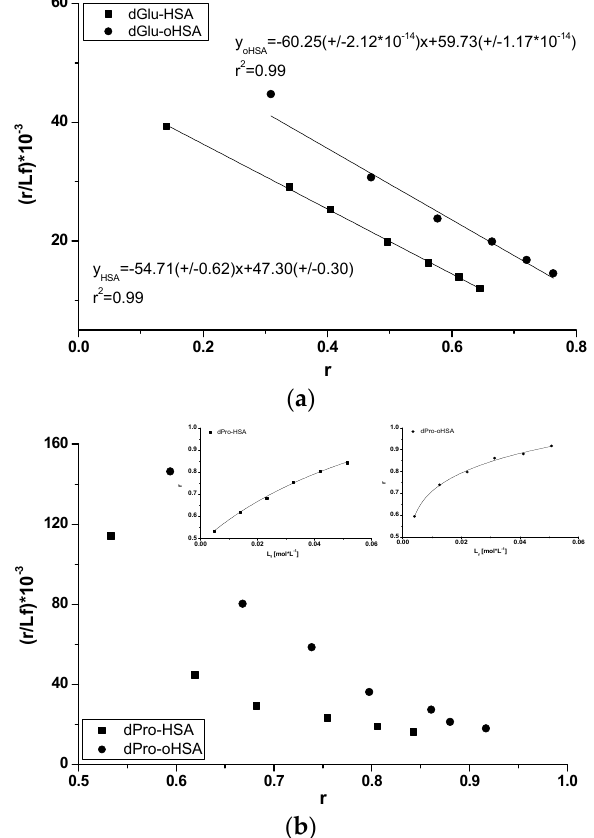
Figure 7. Scatchard curve for ( a ) dGlu-HSA, dGlu-oHSA and ( b ) dPro-HSA, dPro-oHSA systems; λ ex 350 nm. [HSA] = [oHSA] 1·10 − 5 mol·L − 1 , [dGlu] 0.5·10 − 5 mol·L − 1 –6·10 − 5 mol·L − 1 . In the insert the binding isotherms for dPro-HSA and dPro-oHSA systems.